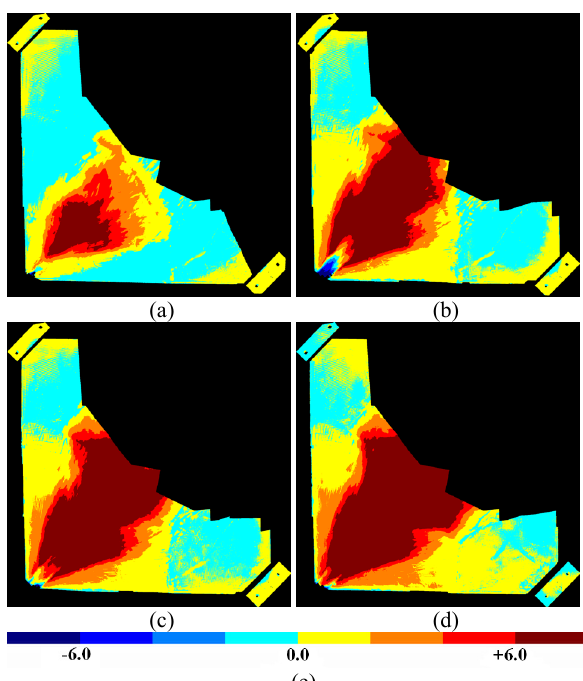
Figure 4. The spatial comparisons between the DEMs of epoch0 −epoch1 (a), epoch0 –epoch2 (b), epoch0–epoch3 (c), epoch0–epoch4 (d), and the residual bar in millimetres unit (e).